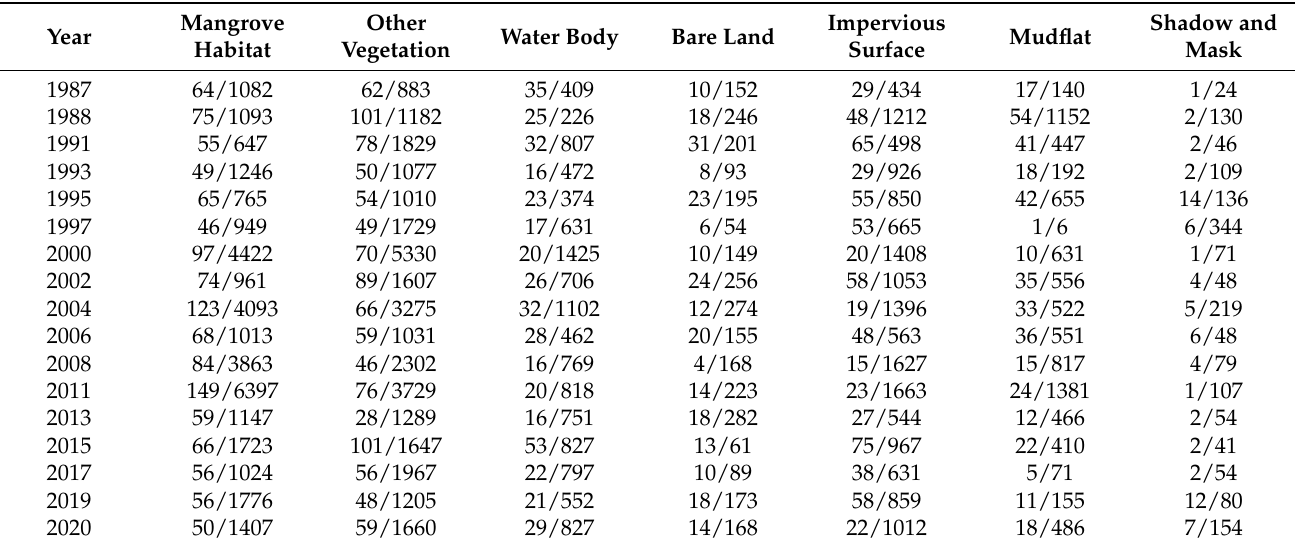
Table 2. The numbers of polygon and pixel samples selected for training and testing classification rules for Landsat and SPOT data, presented as